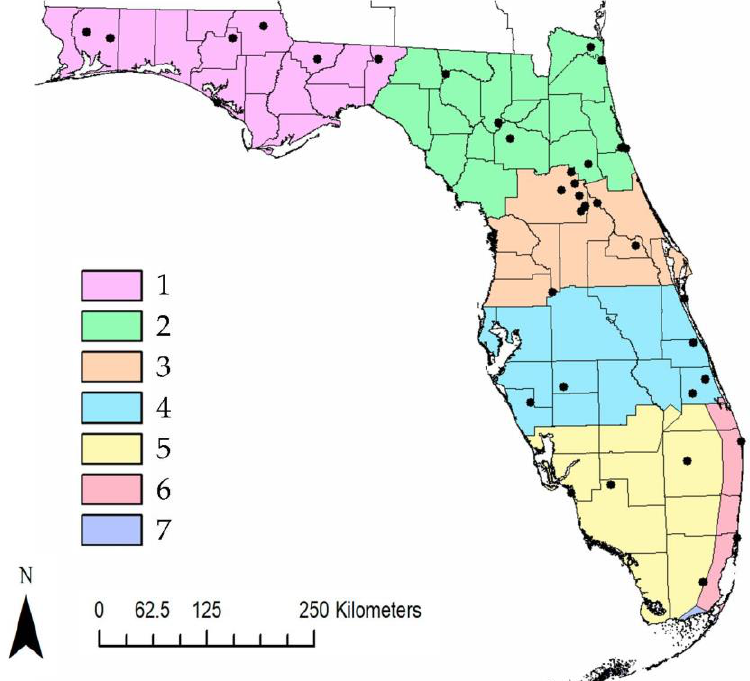
Figure 1. Map of the seven climatic regions of Florida. Each color represents a climatic region going from north to south. Black dots indicate field sites where ticks were collected.